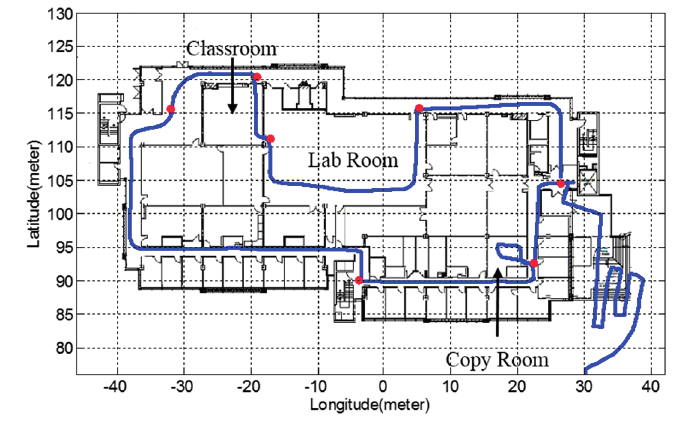
Figure 5. Indoor part